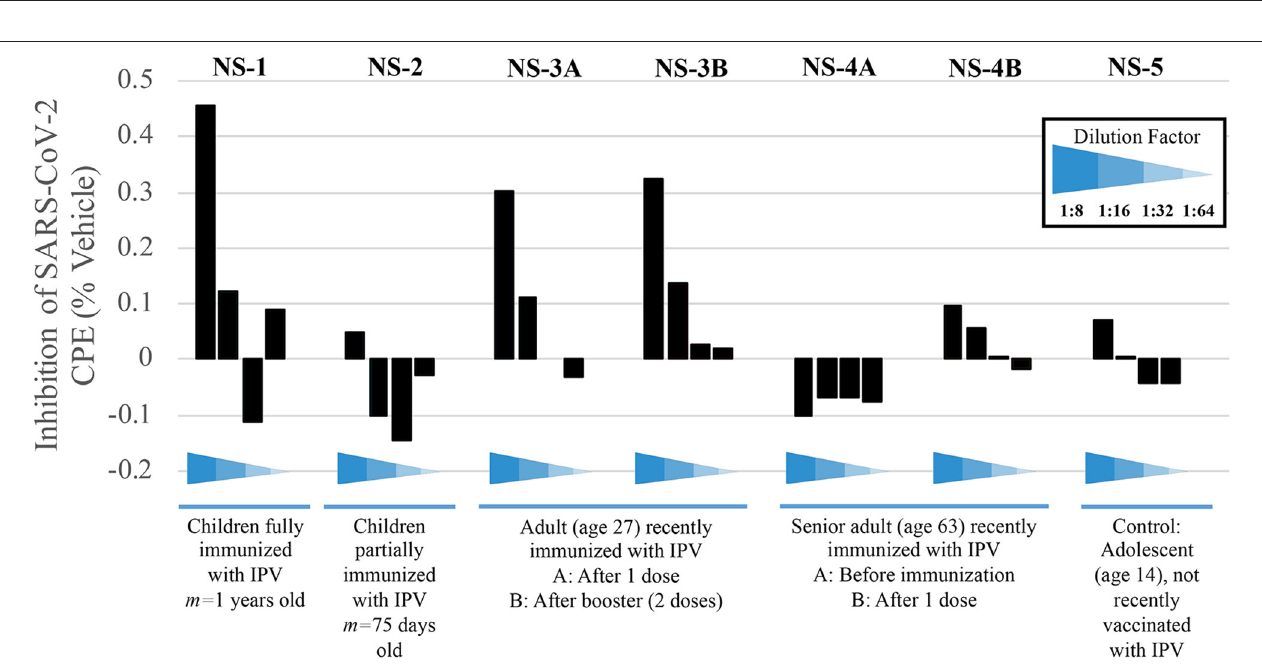
FIGURE 4 | Poliovirus vaccination shows significant increase in RdRp reactivity. (A) Comparison of sera ( N = 204) before and after poliovirus immunization showed that adults gained significantly more antibodies following the poliovirus vaccination (Two-tailed t -test, *** p < 0.001). (B) Comparison of pediatric and immunized adult sera showed no significant differences between the two groups (Two-tailed t -test, p = 0.85), with immunized adults displaying similar antibody responses as immunized children.